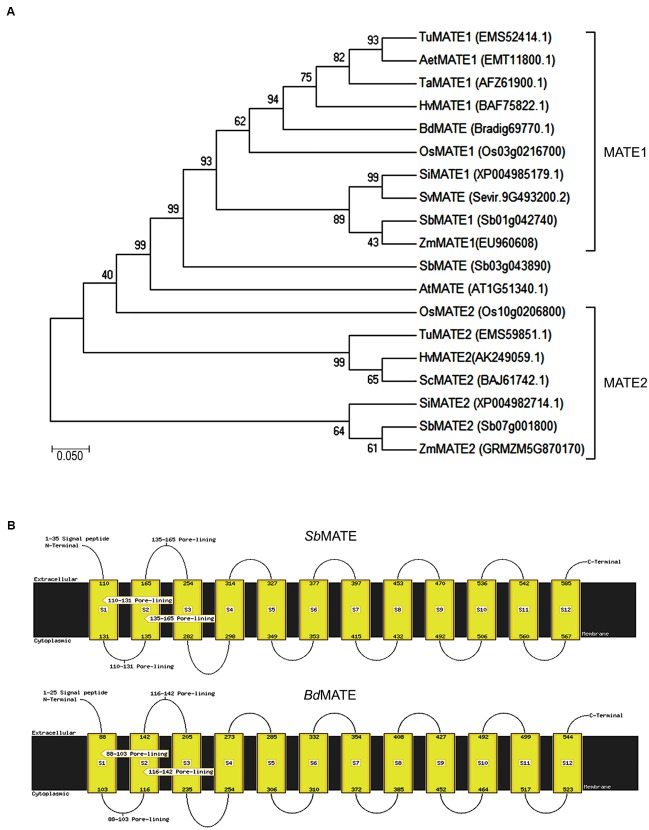
(A) Phylogenetic tree based on amino acid sequences. The analyses were conducted in MEGA7 software (Kumar et al., 2016) using the Maximum Likelihood method and bootstrap consensus tree inferred from 10000 replicates. The amino acids sequences of these proteins were obtained from NCBI and Phytozome. (B) Transmembrane domains of the BdMATE and SbMATE generated by FFPRED and MEMSAT-SVM (Nugent and Jones, 2009; Buchan et al., 2010).